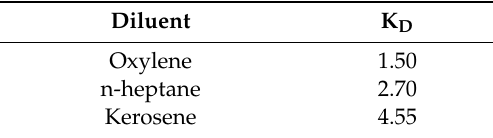
Table 2. Distribution coe ffi cient of di ff erent